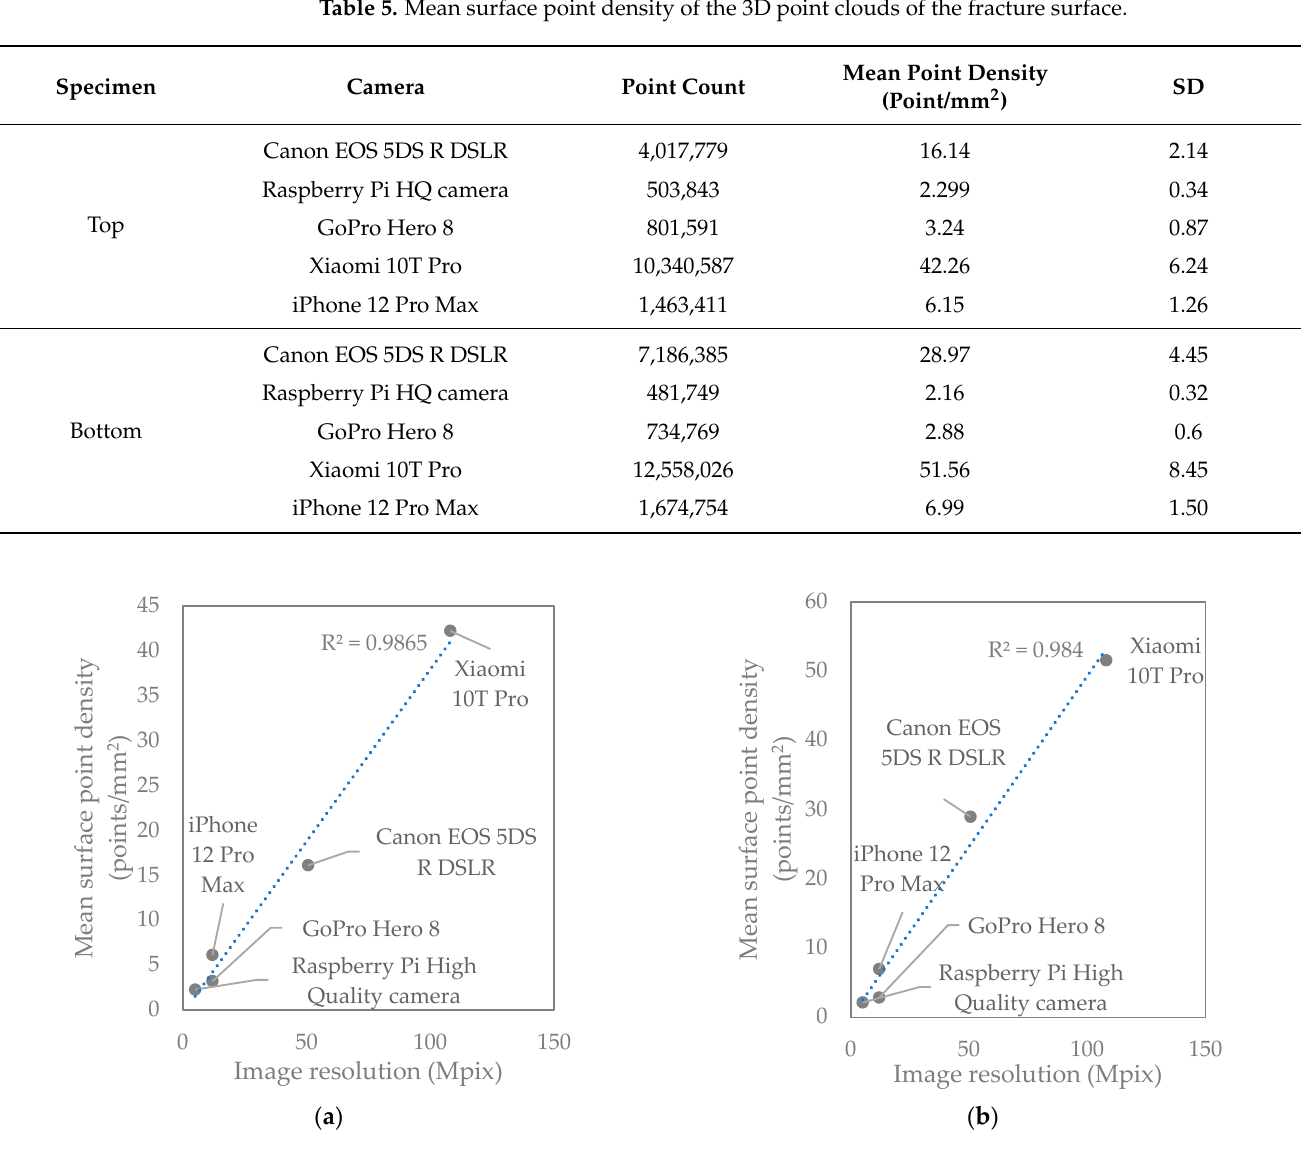
Figure 6. Mean surface point density of the top ( a ) and bottom ( b ) half of the sample as a function of camera resolution in megapixels. Table 5. Mean surface point density of the 3D point clouds of the fracture surface.